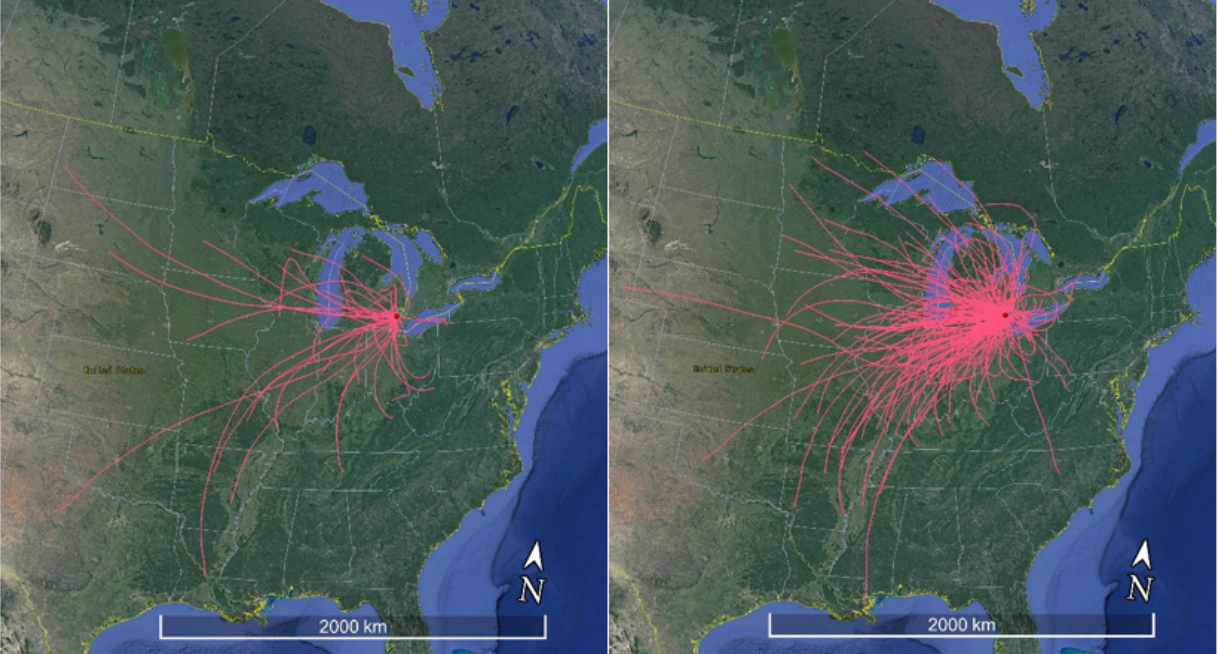
Figure 6. Back trajectories of AQHI = 4 days in cold season ( left ) and warm season ( right ). The red dot is Windsor.